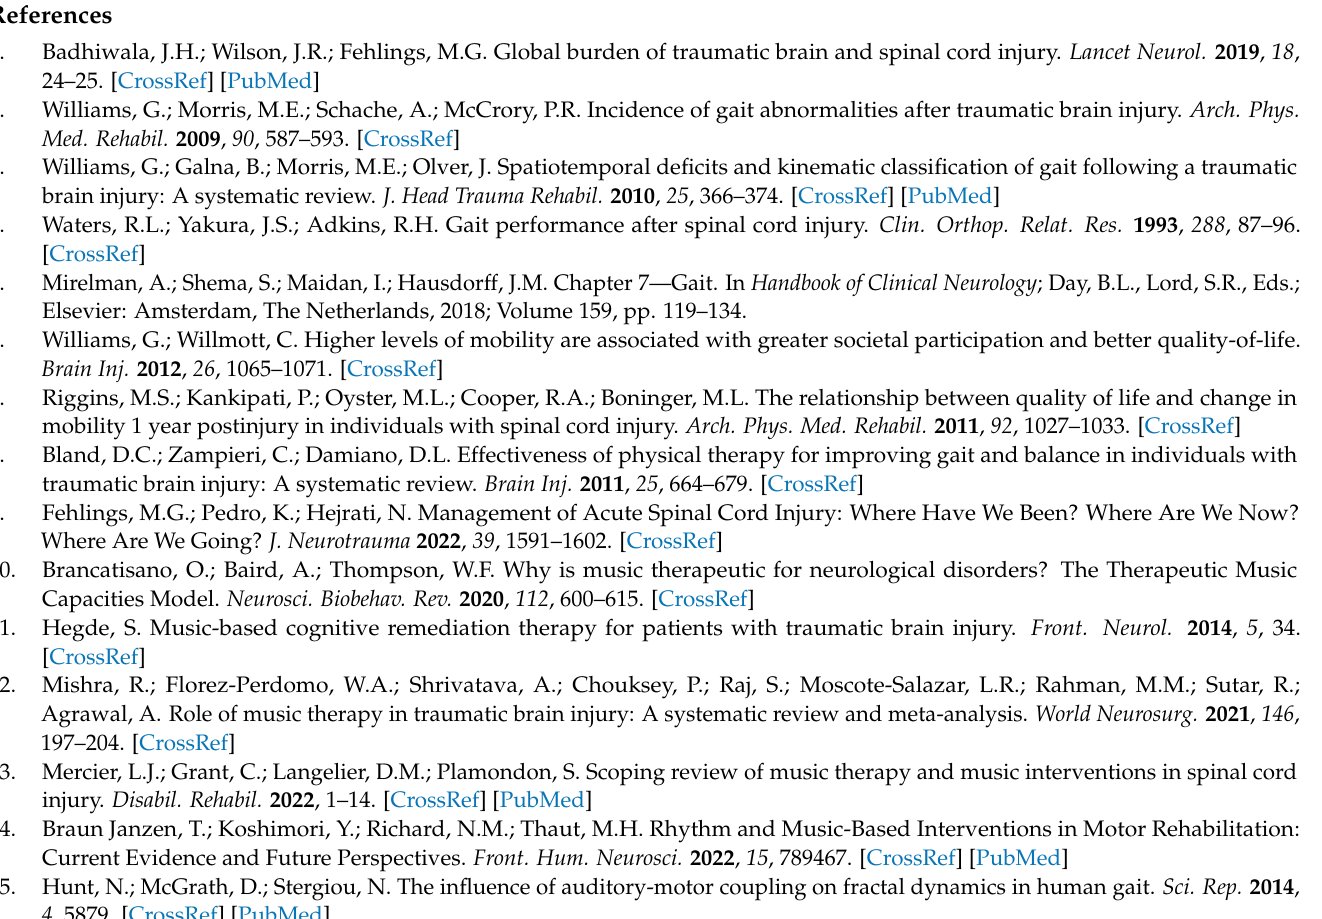
Table S2: Search keywords, Figure S1: Forest plot depicting the results of leave-one-out sensitivity analysis for the effect of MT on overall spatiotemporal gait outcomes in people with traumatic brain injury, Figure S2: Forest plot depicting the results of leave-one-out sensitivity analysis for the effect of MT on gait speed in people with traumatic brain injury, Figure S3: Forest plot depicting the results of leave-one-out sensitivity analysis for the effect of MT on cadence in people with traumatic brain injury, Figure S4: Forest plot depicting the results of leave-one-out sensitivity analysis for the effect of MT on overall spatiotemporal gait outcomes in people with spinal cord injury, Figure S5: Forest plot depicting the results of leave-one-out sensitivity analysis for the effect of MT on gait speed in people with spinal cord